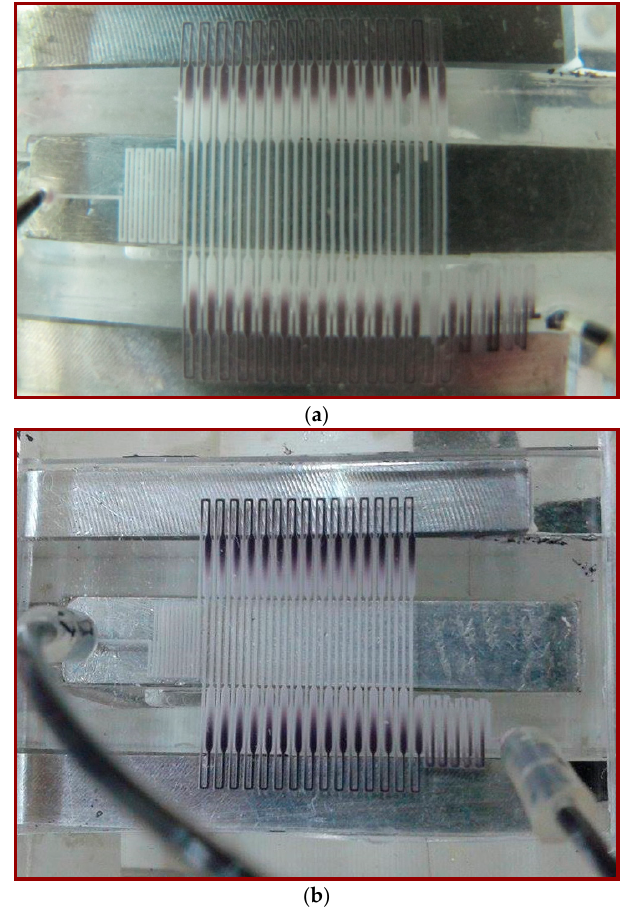
Figure 7. The temperature distribution visualized using a thermally sensitive dye. The fluid with dye is moving at the flow rate at ( a ) 0.2 μL/min and ( b ) 10 μL/min.